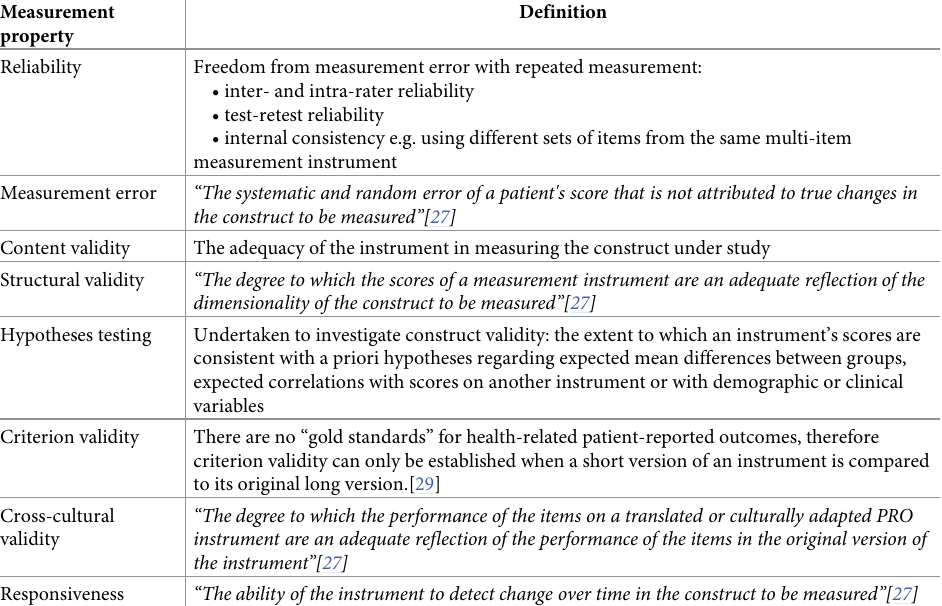
Table 2. Definitions of measurement